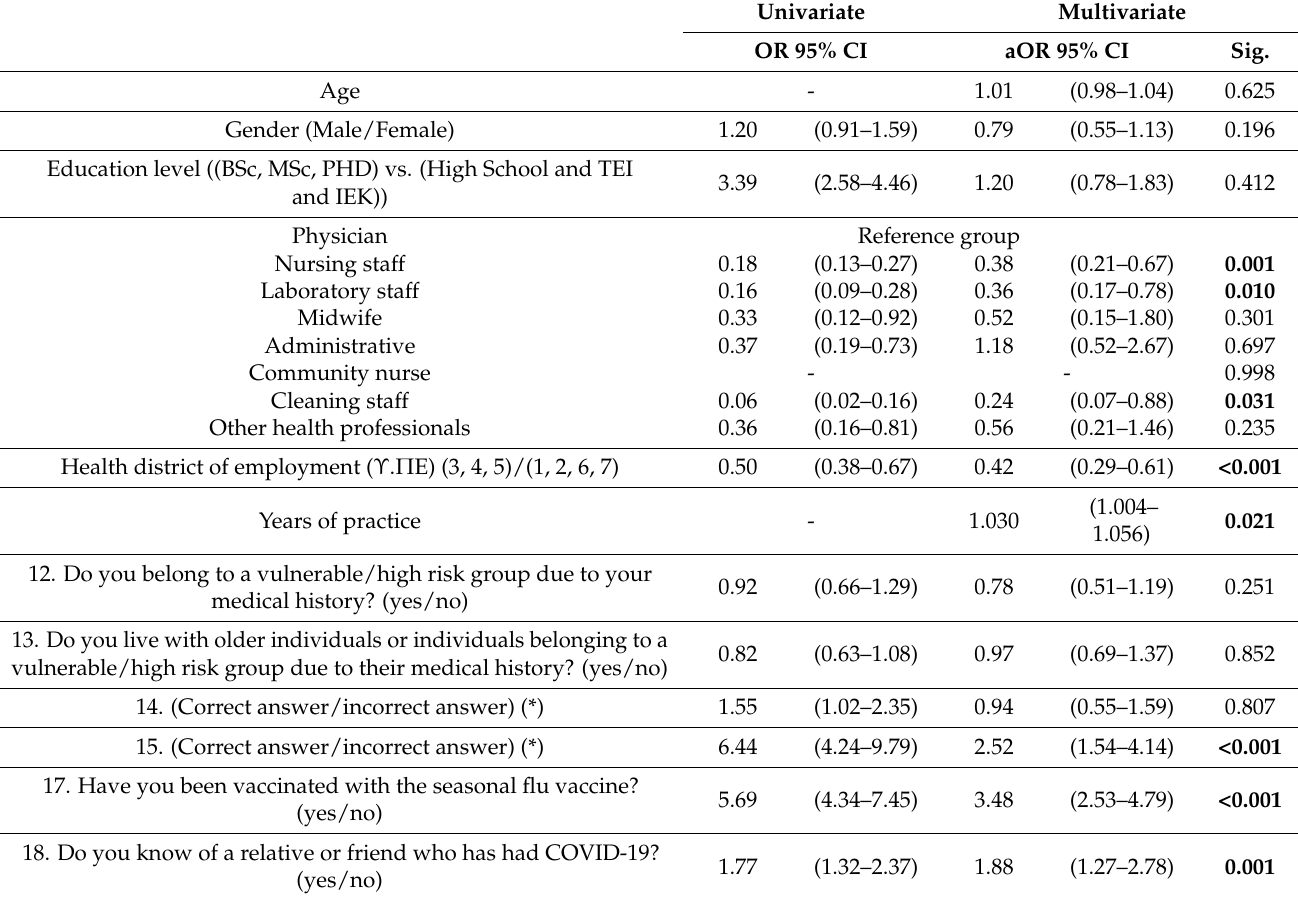
Table 5. Factors associated with COVID-19 vaccine acceptance, expressed with adjusted odds ratio in multivariable analysis. Univariate Multivariate OR 95% CI aOR 95% CI